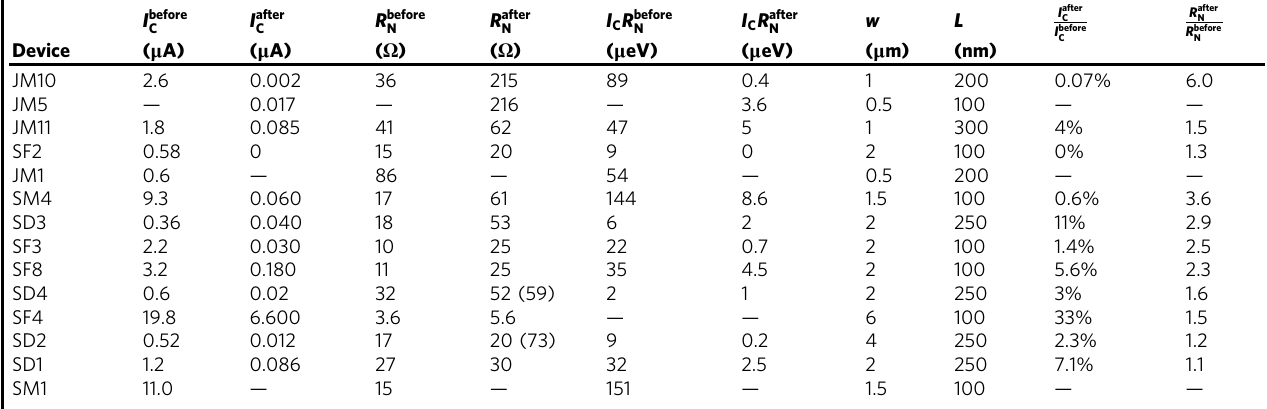
Table 1 Relevant parameters for all the measured devices before and after the thermal cycle I before C